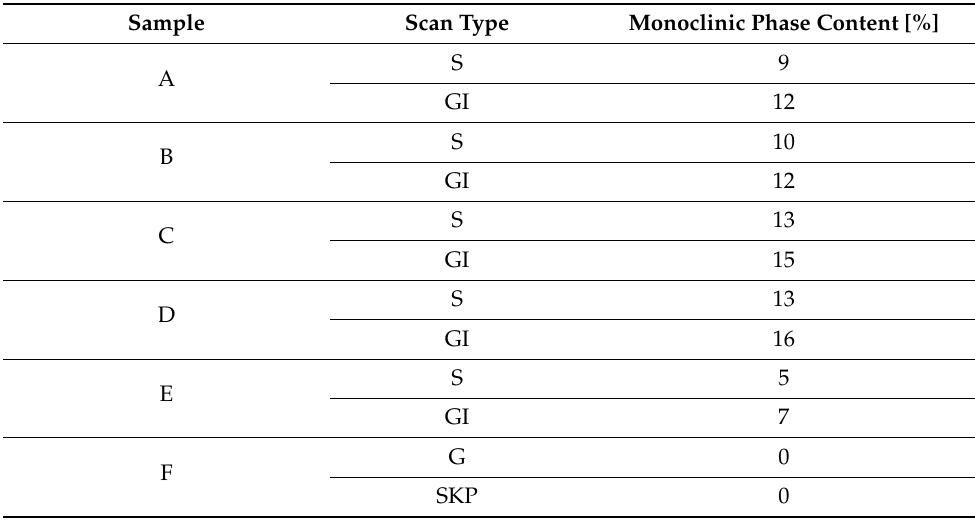
Table 2. Content of the monoclinic phase in the tested samples.